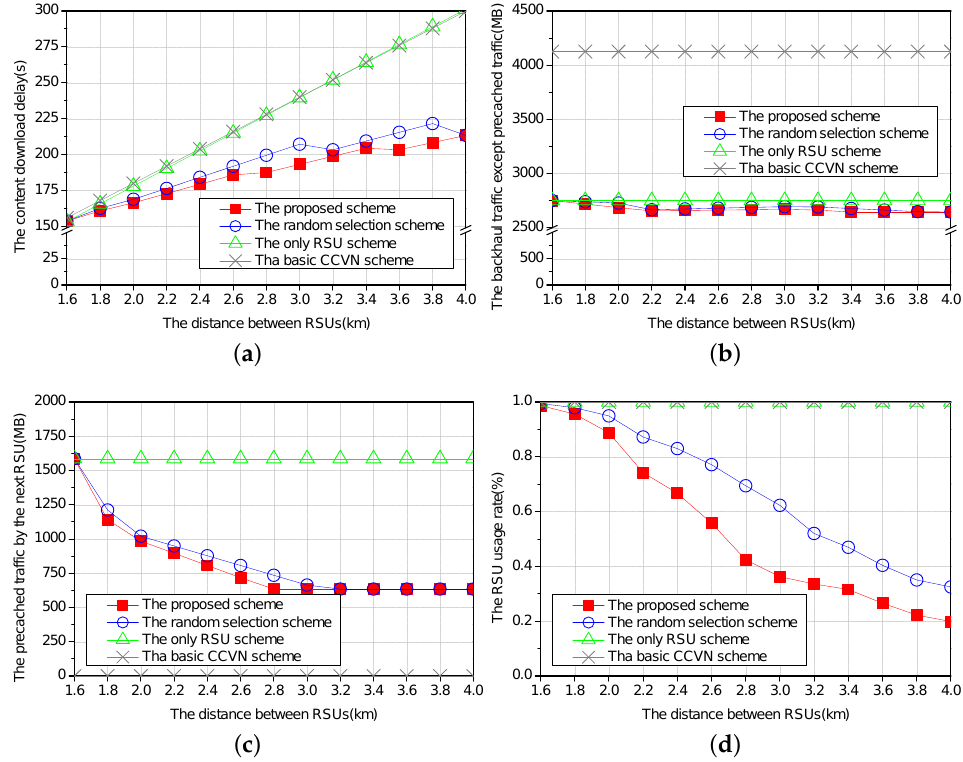
Figure 3. Simulation results for different distances between RSUs: ( a ) the content download delay, ( b ) the backhaul traffic except precached traffic, ( c ) the precached traffic by next RSU and ( d ) the RSU usage